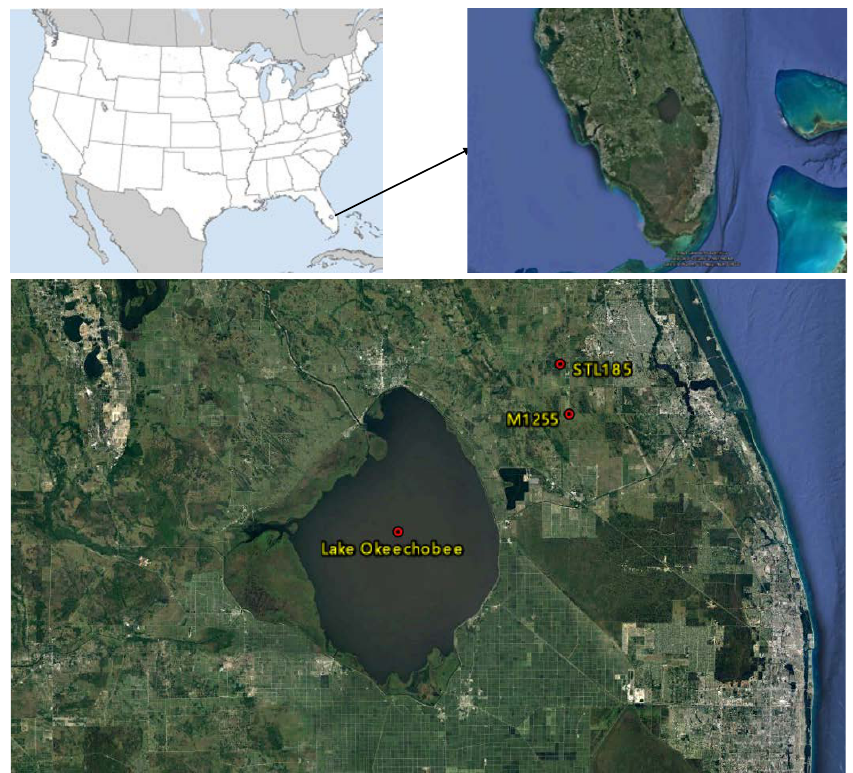
Figure 5. Location map of the United States and observation wells (Source: Imagery © Data SIO, NOAA, U.S. Navy, NGA, GEBCO, Image Landsat/Copernicus).